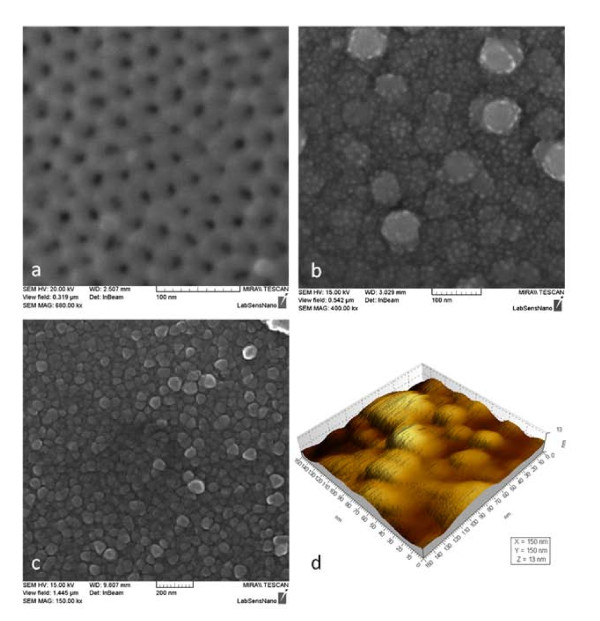
SEM and AFM images. SEM characterization of the (a) alumina template, (b) TiO2 QDs on Ti grains, and (c) Ti layer. (d) AFM image of the Ti layer.